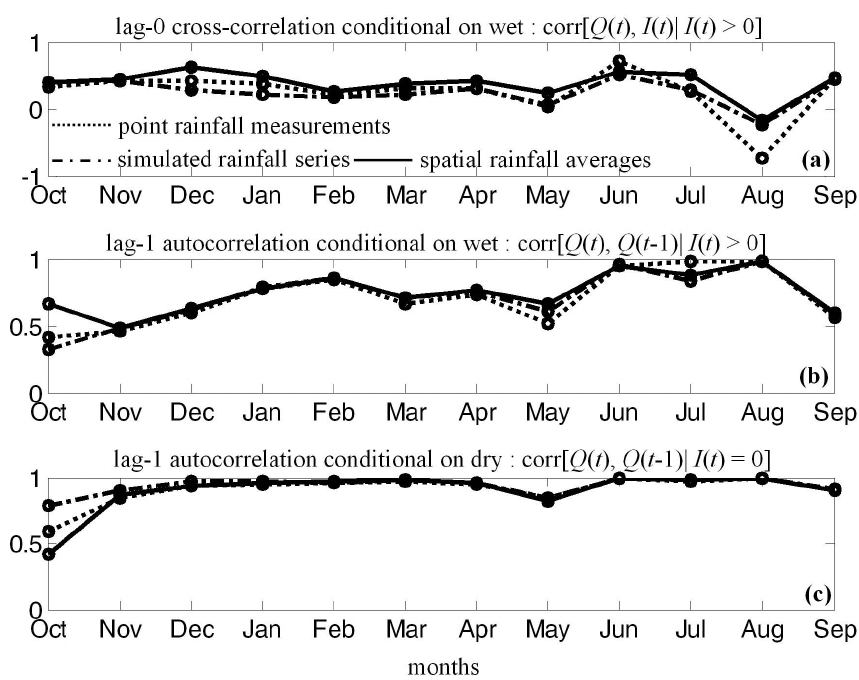
Fig. 17. (a) lag-0 cross-correlation between daily rainfall and runoff values conditional on wet conditions { i.e. corr[ Q(t) , I(t) | I(t)> 0] } , (b) lag-1 autocorrelation of daily river discharges conditional on wet conditions (i.e. corr[ Q(t) , Q(t − 1) | I(t)> 0]), (c) same as (b) but for the case of dry conditions (i.e. corr[ Q(t) , Q(t − 1) | I(t) =0]). Dotted lines have been obtained using the historical rainfall and runoff time series at the location of the hydroelectric plant (HP, point A in Fig. 2), solid lines using the spatially averaged rainfall intensities, and dashed- dotted lines have been calculated by ensemble averaging the results from 100 realizations of spatial rainfall estimates, using the procedure described in Sects.